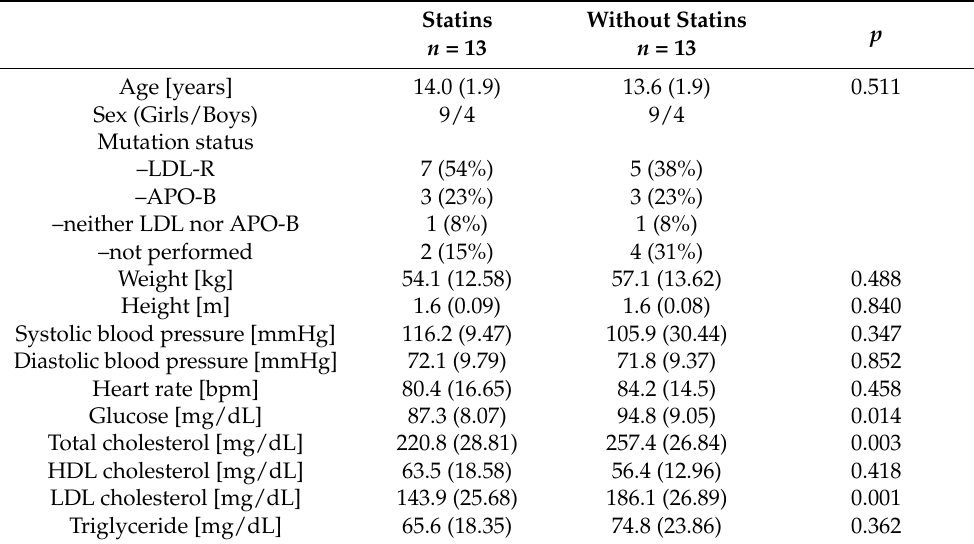
Table 1. Characteristics of studied children with familial hypercholesterolemia treated with statins and the diet or treated with an exclusive low-cholesterol diet for 6 months. Data are presented as means and standard deviations where applicable. A Mann–Whitney two-sided rank U-test was used. Statins Without Statins n = 13 n = 13